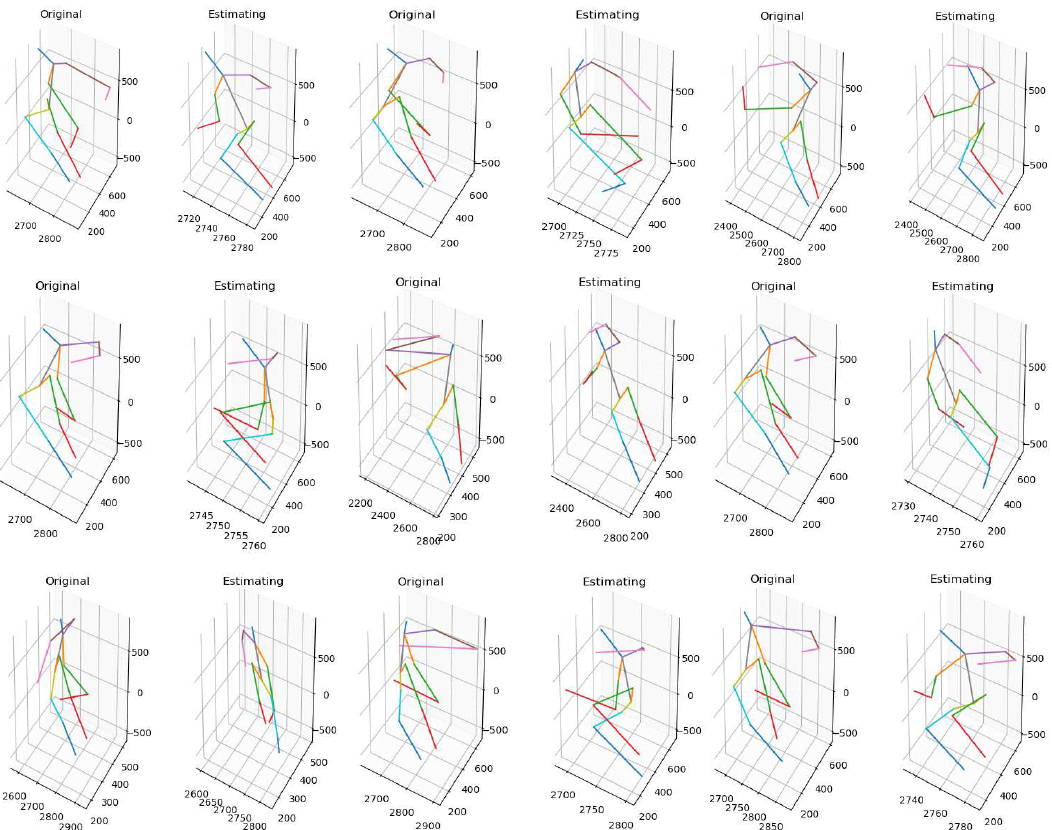
Fig. 15: The results of 3-D human pose estimation. Each block is a pair of correspondences between the 3-D pose of the ground truth data (ground truth - original) and the estimated 3-D human pose (estimating). Each pair of frames in a block has been synchronized to the coordinate